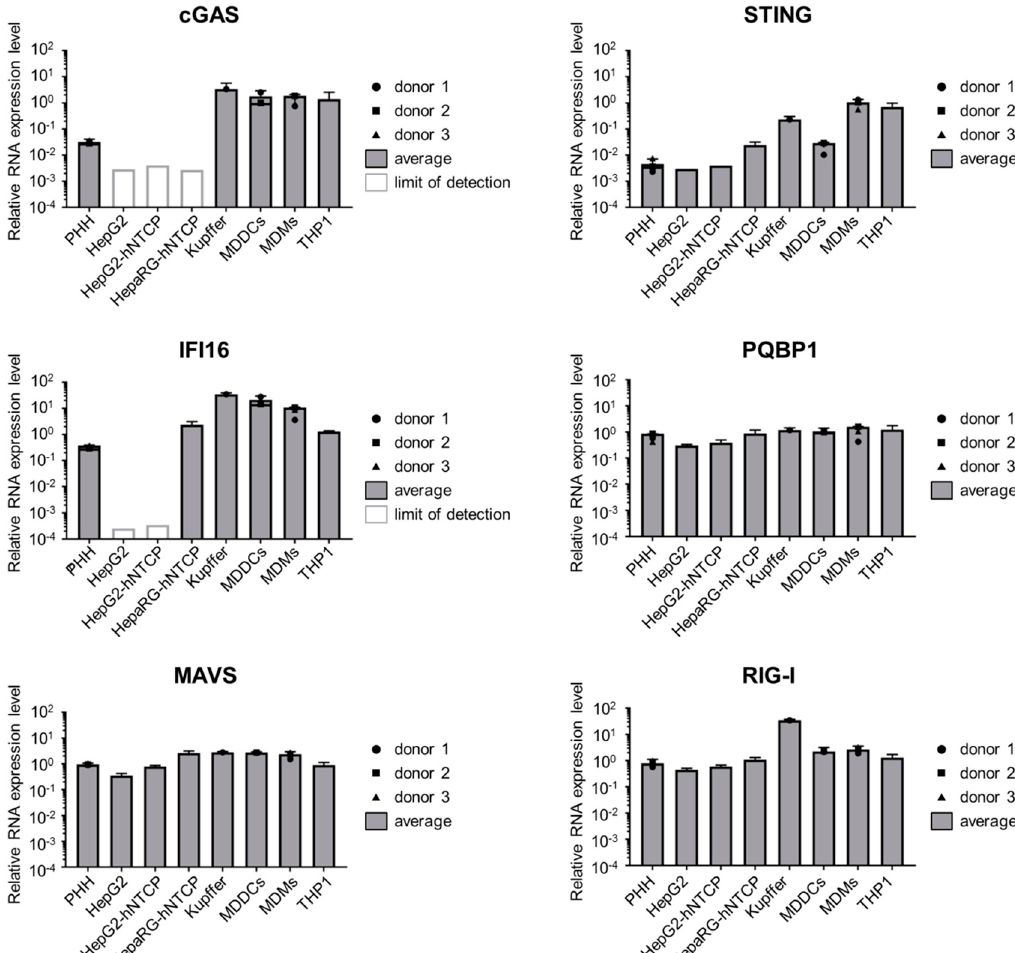
Figure 3. Hepatocytes express a low level of components of the DNA-sensing pathway. cGAS, STING, IFI16, PQBP1, MAVS and RIG-I mRNAs were quantified by RT-qPCR in the indicated cell types and normalized to the geometric mean of RPL13A and TBP mRNAs. For primary cells, the average and SEM of technical triplicates from 3 (PHH and MDMs), 2 (MDDCs) or 1 (Kup ff er cells) donors are